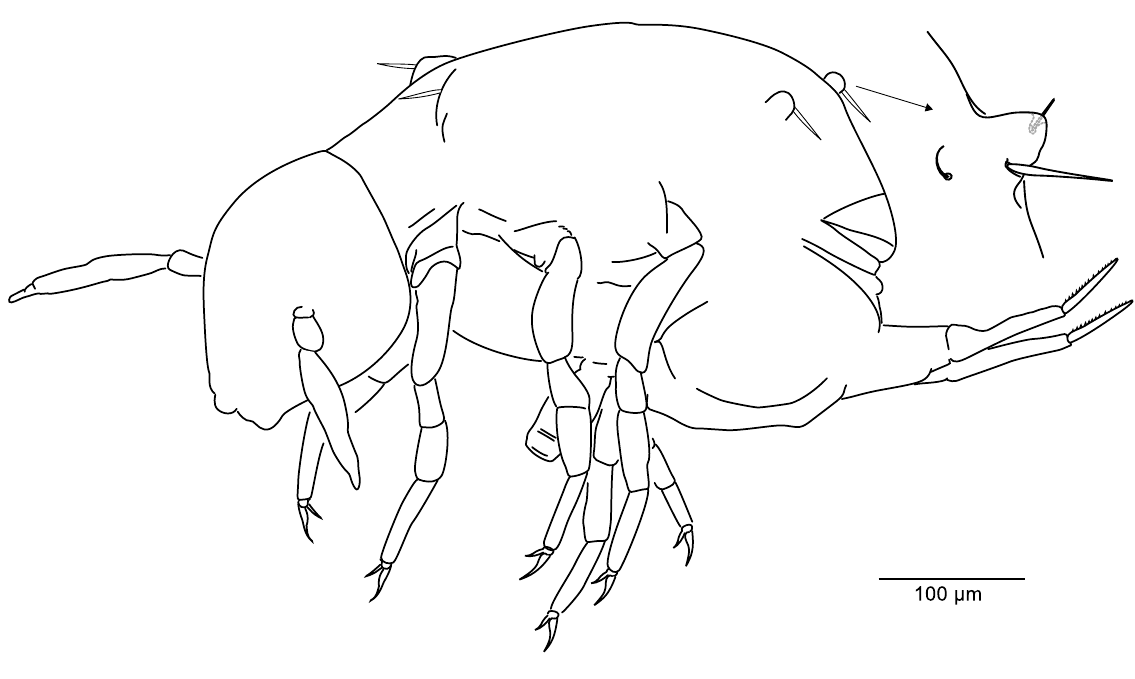
Fig. 1. Spinaethorax adamantis sp. nov., habitus, with enlargement of the protuberance bearing wax rod secretory element of sf6